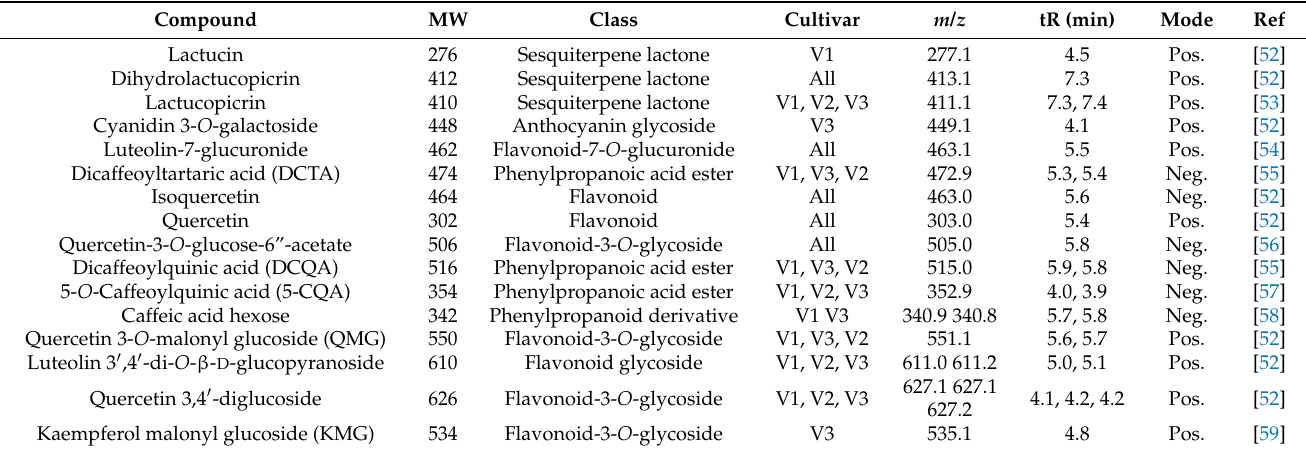
Table 3. Dereplicated metabolites from the three lettuce cultivars V1, V2 and V3 under +S and − S conditions. MW: Molecular weight, t R : Retention time, Pos.: Positive mode, Neg: Negative mode, Ref: Reference for dereplication.